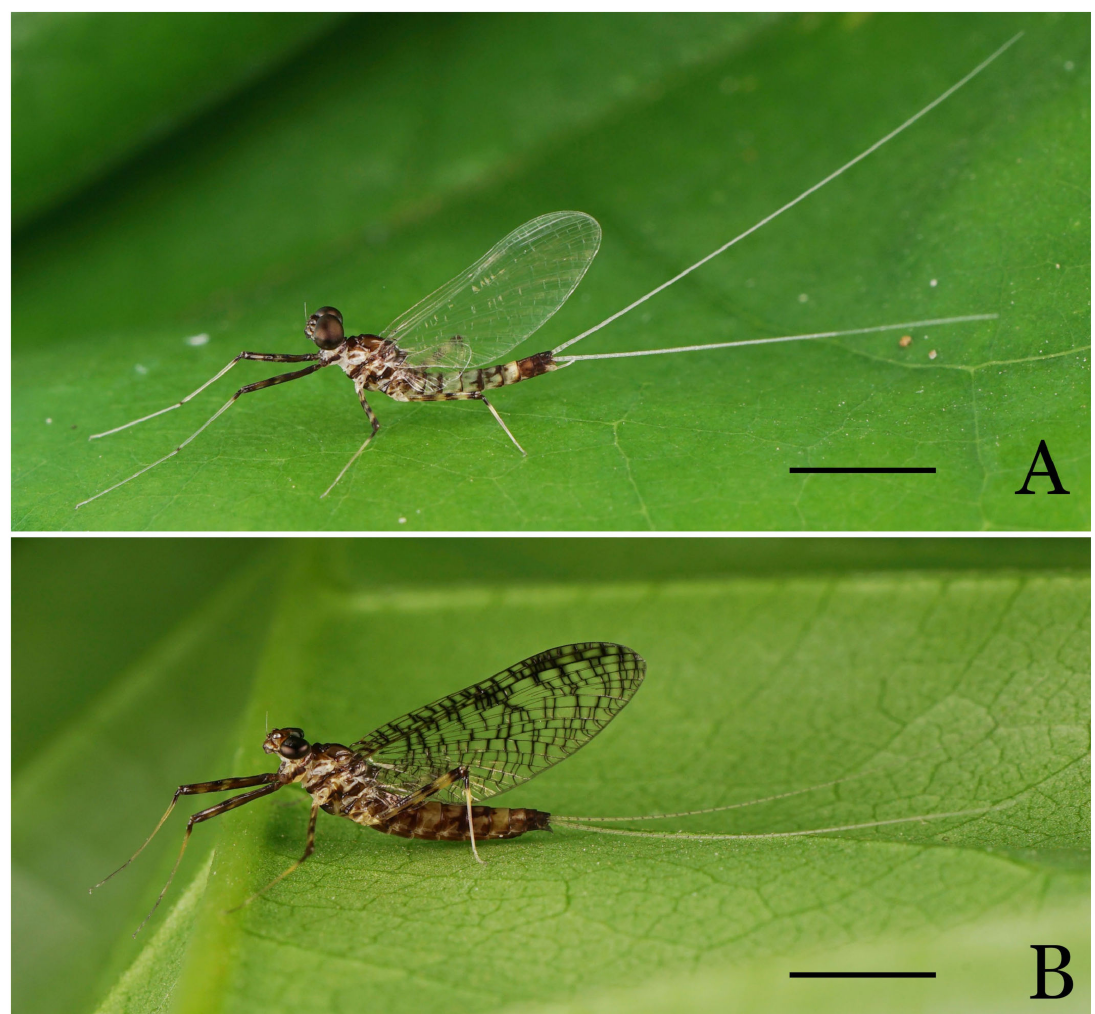
Figure 5. Imago of Maculogenia ngi (digital photos): ( A ) male imago; ( B ) female imago. Scale bars: ( A , B ) = 5.0 mm.